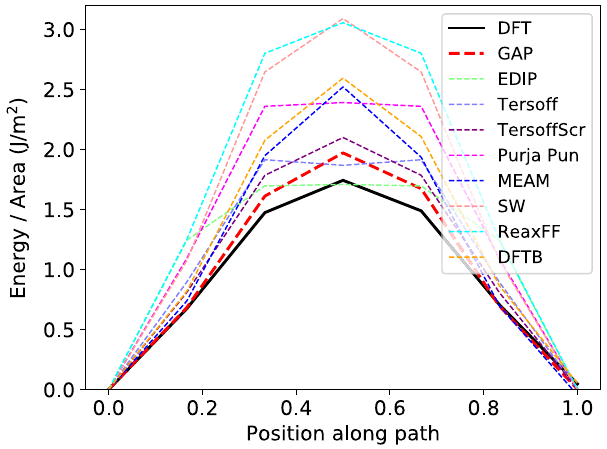
FIG. 22. Relaxed glide-plane generalized stacking-fault ener- gies along the minimum barrier energy path ½ 112 (cid:3) direction computed with the DFT (solid lines), GAP (red dashed lines with symbols), and other interatomic potentials (other color dashed